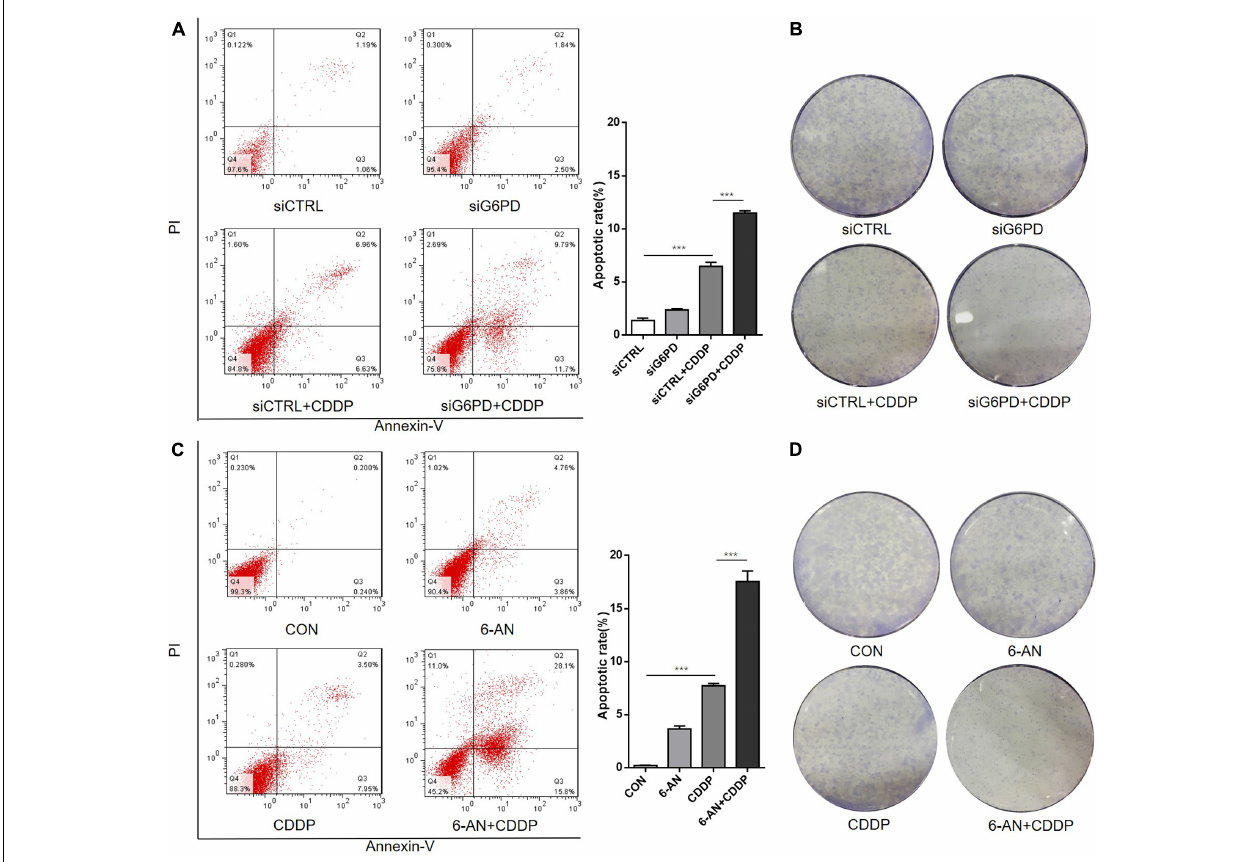
FIGURE 5 | Inhibition of G6PD sensitizes the A549/DDP cells to cisplatin by inducing apoptosis and inhibiting colony formation. (A) A549/DDP cells transfected with siRNA were cultured with or without cisplatin for 48 h followed by staining with Annexin-V/PI. The lower right quadrant (Annexin-V+/PI–) indicates the percentage of early apoptosis. (B) The cells were stained with crystal violet for colony formation after culturing for an additional 10 days. (C) A549/DDP cells were treated with cisplatin and 6-AN separately or in combination for 48 h followed by staining with Annexin-V/PI. (D) Cells were stained with crystal violet for colony formation after culturing for an additional 10 days. Data are presented as the means ± SD ( n = 3), and significant differences are indicated as ∗ P < 0.05, ∗∗ P < 0.01, and ∗∗∗ P <